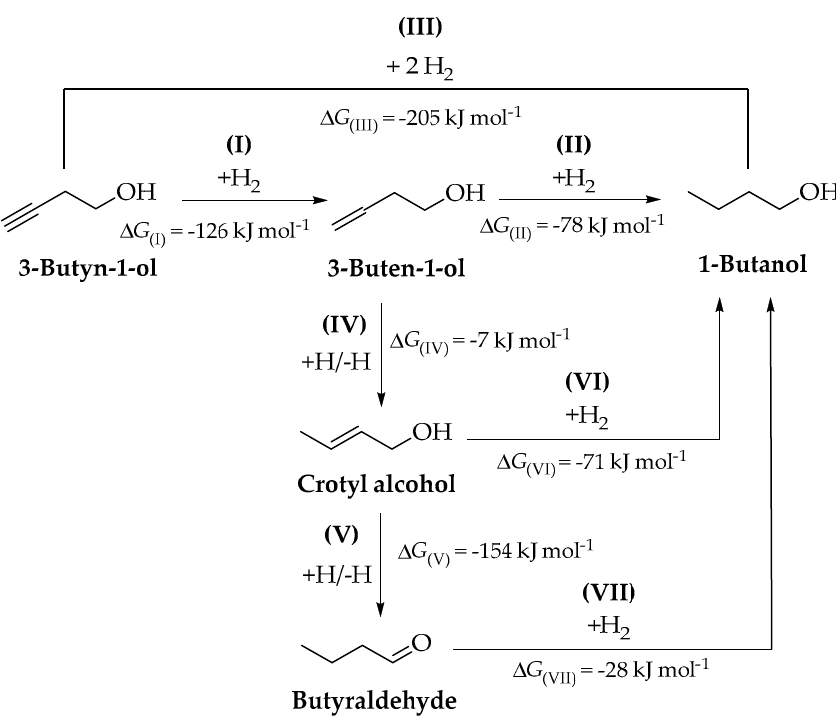
Figure 3. Reaction scheme with Gibbs free energies ( ∆ G (I-VII) ) for each step in the hydrogenation of primary (3-butyn-1-ol) alkynol: Reaction conditions : T = 373 K, P = 1 atm.